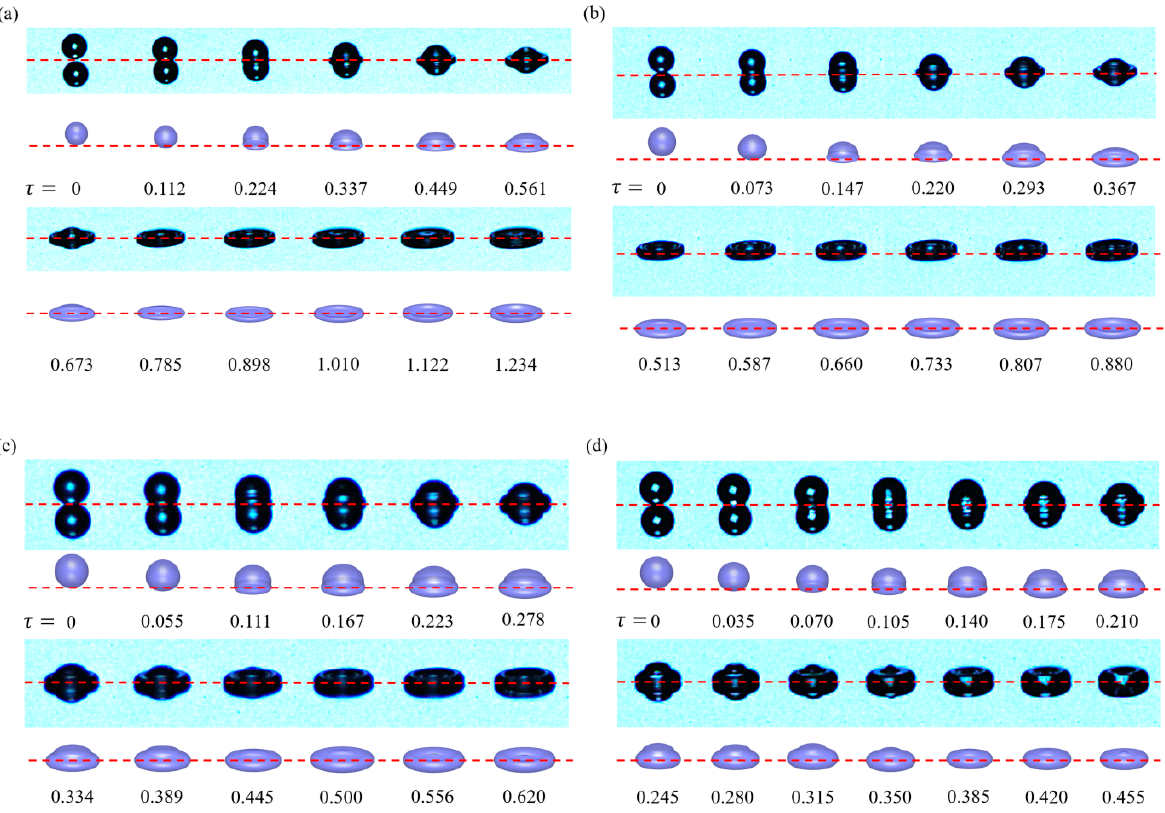
Figure 3. Time sequences of ultra-pure water droplet impact a stainless-steel smooth surface arrayed in non-dimensional time τ under ( a ) We = 30 and Re = 750, ( b ) We = 21 and Re = 612, ( c ) We = 10 and Re = 421, ( d ) We = 5 and Re = 281 under atmospheric pressure for experimental and numerical results. The red dash line denotes the impact horizontal line.